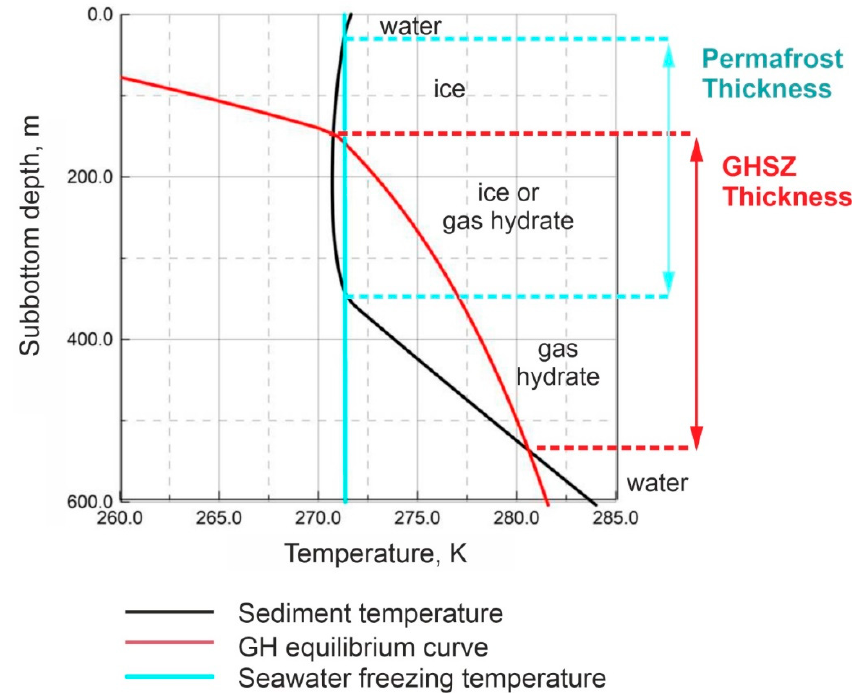
Figure 3. Graphs used to determine the thicknesses of permafrost and the pressure–temperature stability zone of methane hydrate. GH-—gas hydrate, GHSZ—gas hydrate stability zone. stability zone of methane hydrate. GH—-gas hydrate, GHSZ—gas hydrate stability